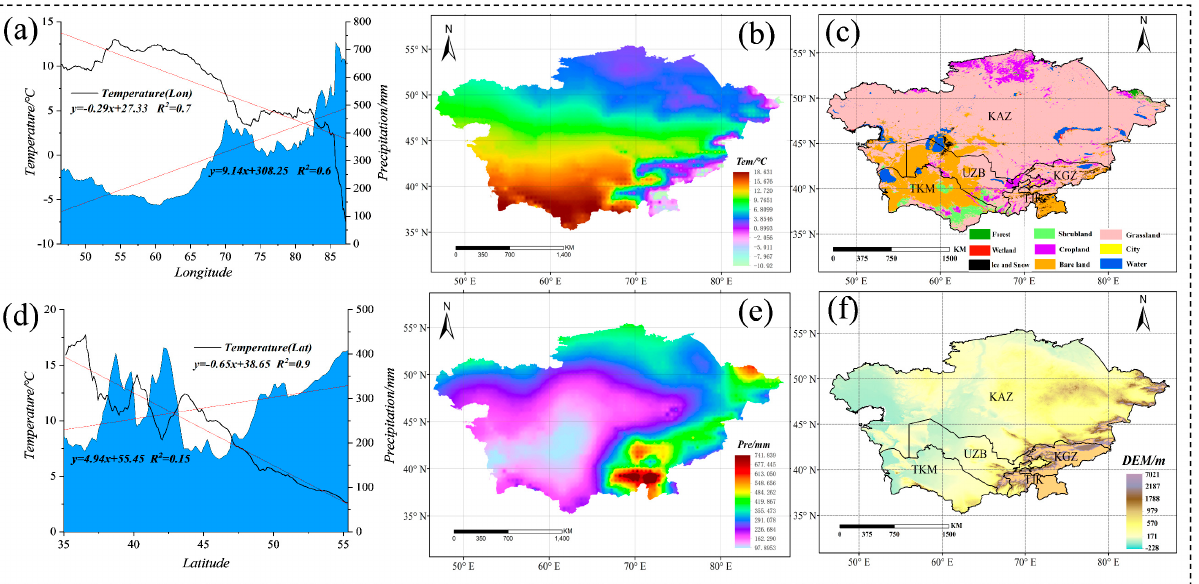
Figure 1. Location of the study area: ( a ) Temperature and precipitation in longitude, ( b ) temperature, ( c ) landcover, ( d ) temperature and precipitation in latitude, ( e ) precipitation, and ( f ) DEM. Drawing NO.: GS (2016)